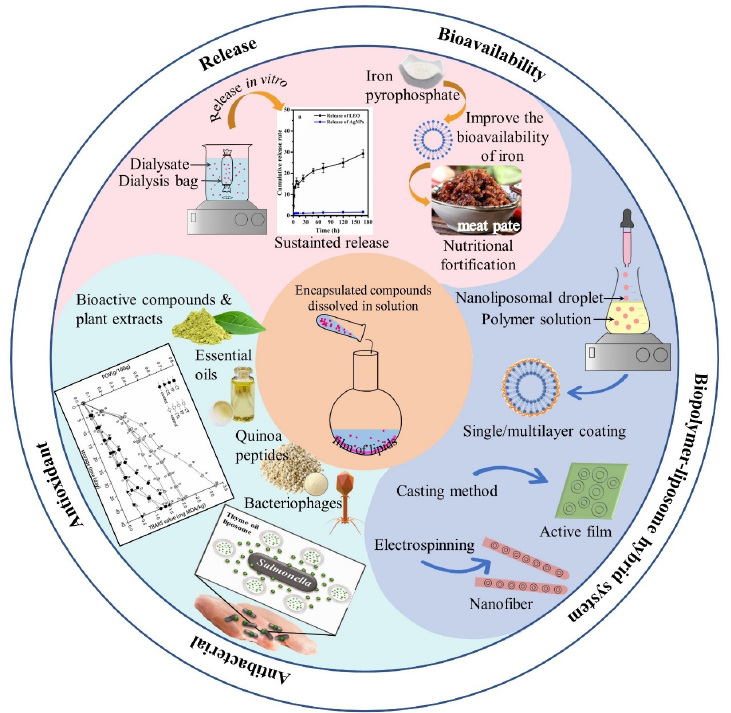
Figure 3. Overview of the applications of liposomes in meat products. (Adopted from Wu, et al. [36]; Cui, et al. [37]; Wu, et al. [38]).